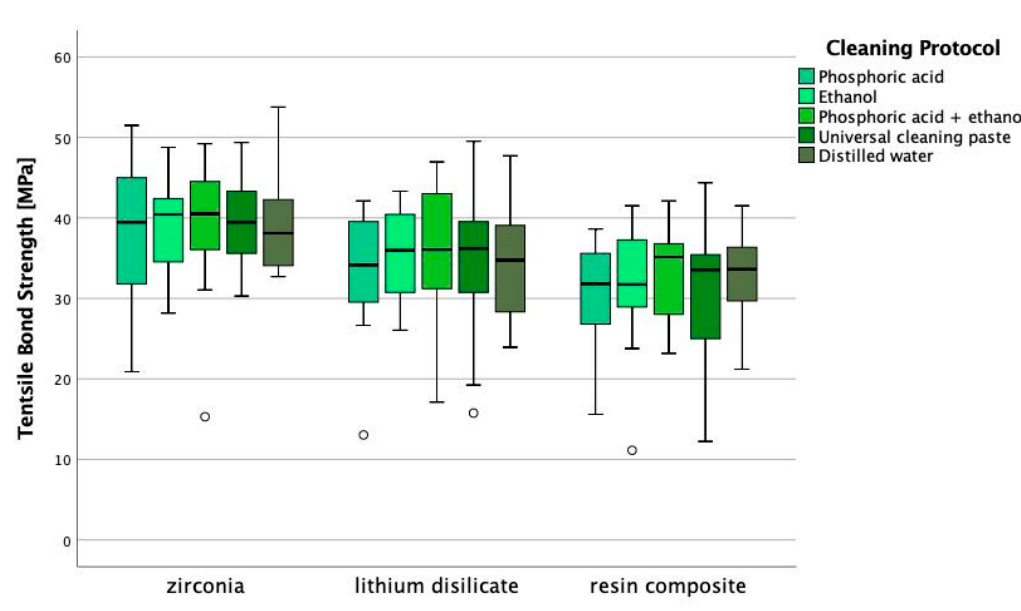
Figure 3. Tensile bond strength in MPa depending on the material and the cleaning protocol.